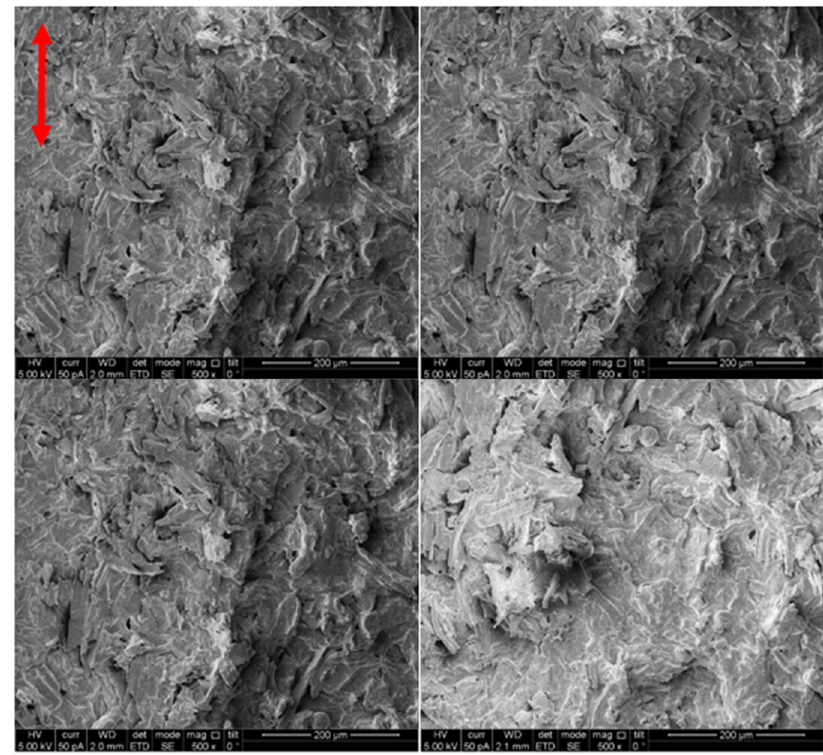
→ ⃗ = 150 mm min ⁄ ⃗ = 150 mm min ⁄ v = 150mm/min (arrows indicating (arrows indicating (arrows indicating